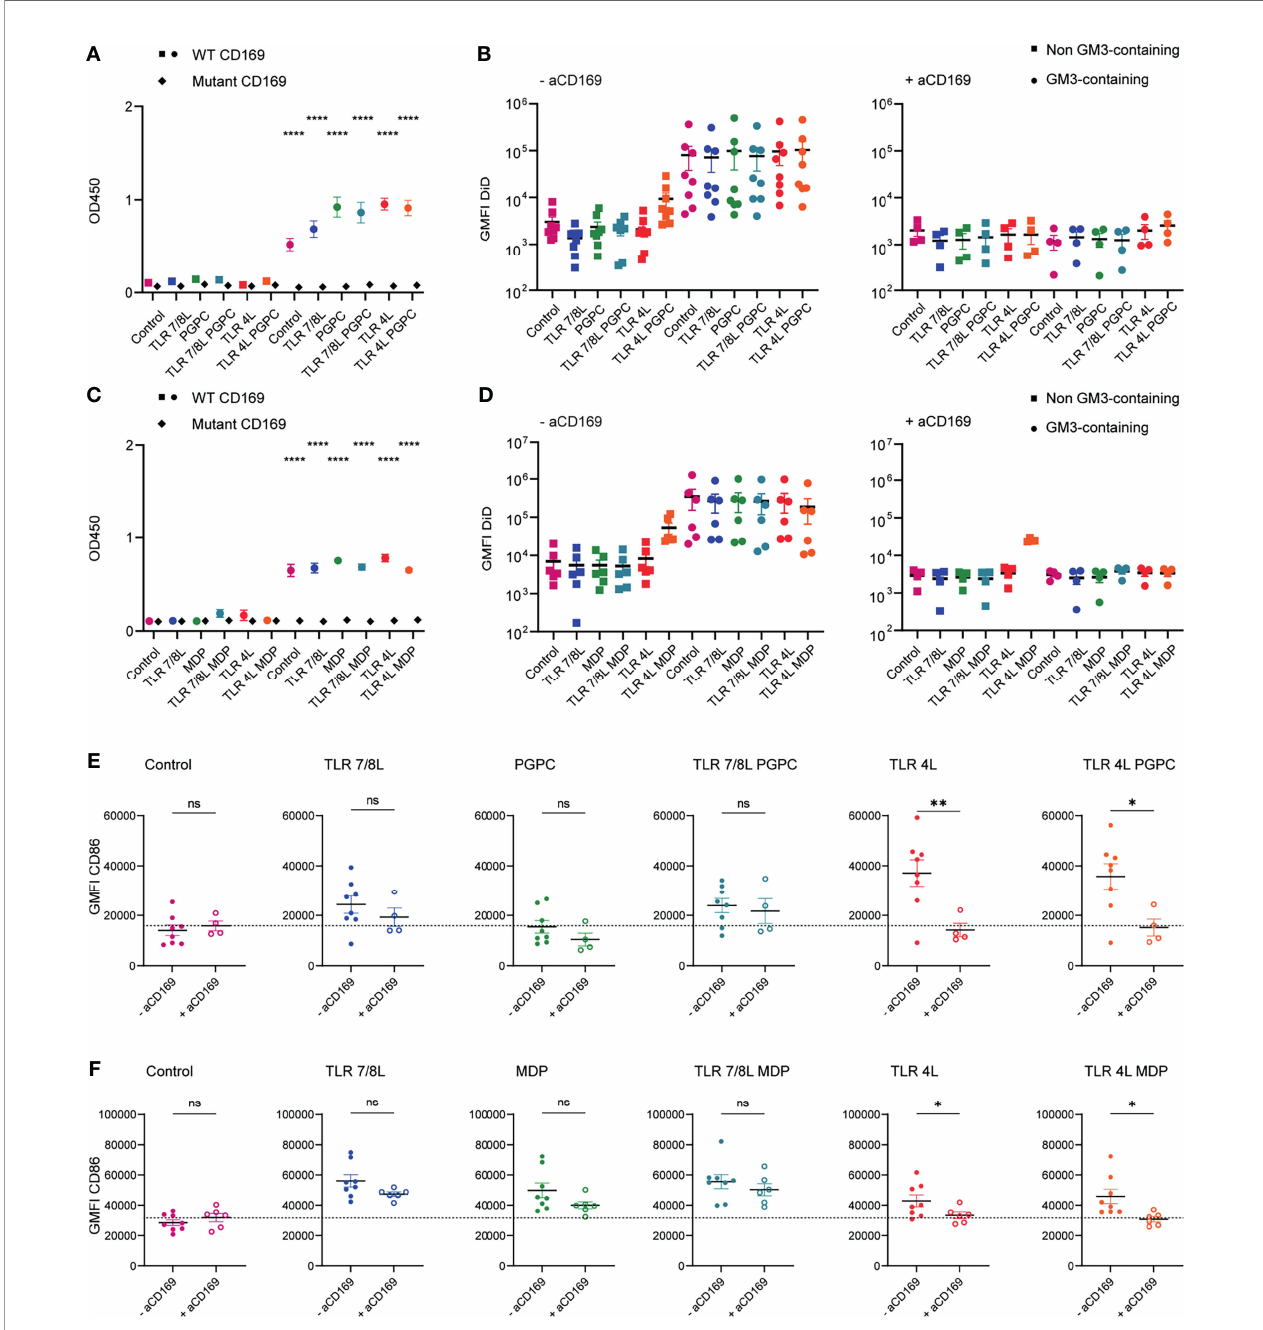
FIGURE 1 | Adjuvant inclusion in GM3 liposomes does not alter binding properties of liposomes and TLRL-inclusion induces moDC maturation. (A) Liposomes were coated on an ELISA plate and the organic solvent was evaporated overnight. Subsequently, binding to WT or mutant CD169 was determined. Indicated is the average ± SEM of three independent experiments, performed in triplicate. Signi fi cance was compared to the non-GM3-containing counterpart. (B) Liposomes were incubated with moDC at 37°C, that were untreated or pretreated with a blocking antibody 15 minutes prior to liposome incubation. Indicated is the average DiD- signal ± SEM ( n = 4-8). (C) As in A, indicated is the average ± SEM of a technical triplicate. Signi fi cance was compared to the non-GM3-containing counterpart. (D) Liposomes were incubated with moDC (that were pretreated with type I IFN) at 37°C, that were untreated or pretreated with a blocking antibody 15 minutes prior to liposome incubation. Indicated is the average DiD-signal ± SEM ( n = 4-6). (E) MoDC were non-treated or incubated with a blocking antibody for 15 minutes and subsequently incubated with liposomes for 45 minutes at 37°C. Next, unbound liposomes were washed away and cells were incubated for 15-18h at 37°C, after which the cells were stained and the expression of CD86 was determined by fl ow cytometry analysis. Indicated is the average geometric mean fl uorescent intensity (GMFI) of CD86 ± SEM ( n = 4-6). (F) as in E, but cells were pretreated with type I IFN (100 IU/mL). Indicated is the average GMFI of CD86 ± SEM ( n = 6-8). *p < 0.05, **p < 0.01, ****p < 0.0001. ns, not signi fi